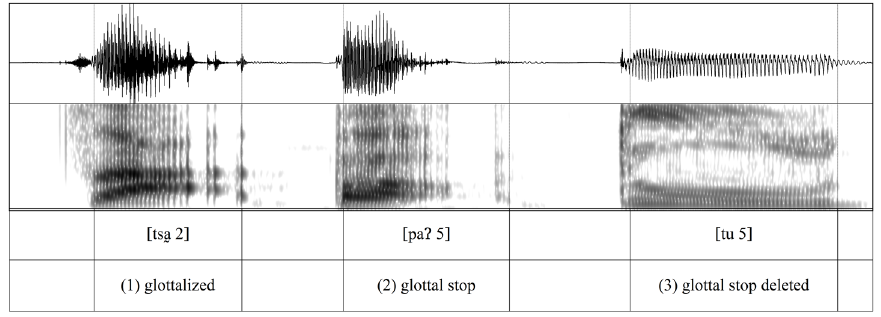
Figure 7. Spectrograms of glottal stops realized as glottalized vowel, full glottal stop and deletion. The underlying form of (1), (2), and (3) is /tsa ʔ 2/ 杂 “mixed”, /pa ʔ 5/ 百 “hundred” and /tu ʔ 5/ 督 “supervise”.